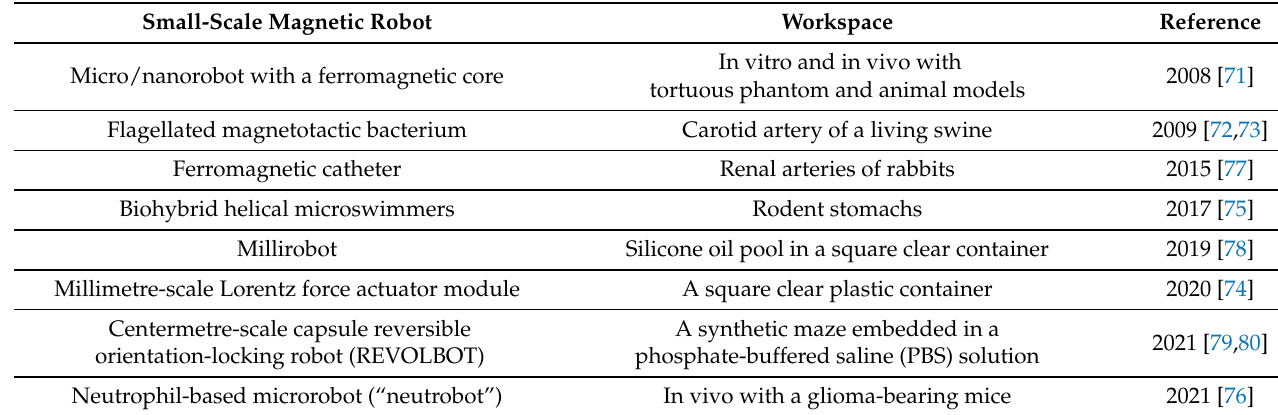
Table 1. Exemplar studies of small-scale magnetic robots with MRI imaging modality.